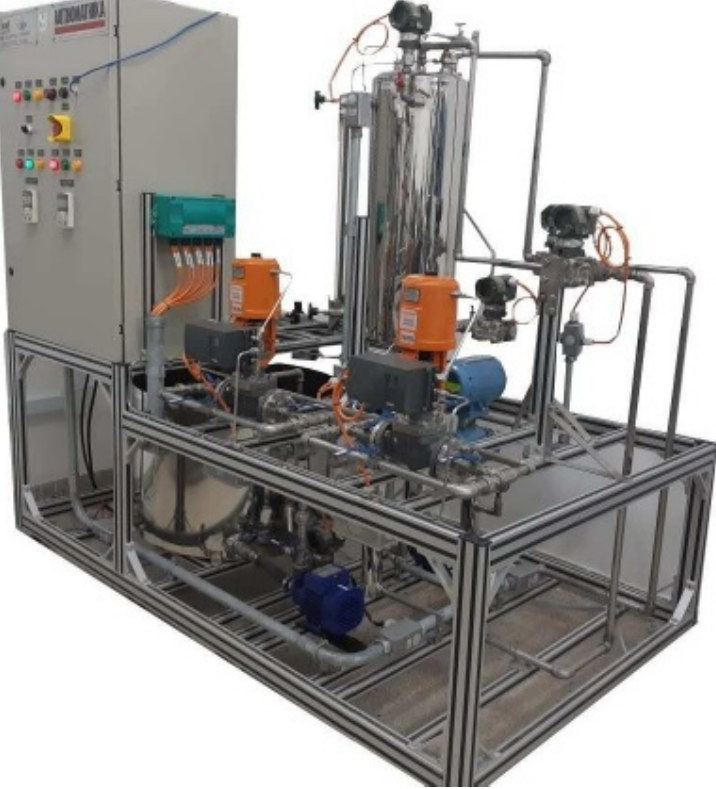
Figure 7. Didactic plant AUTHOMATHIKA